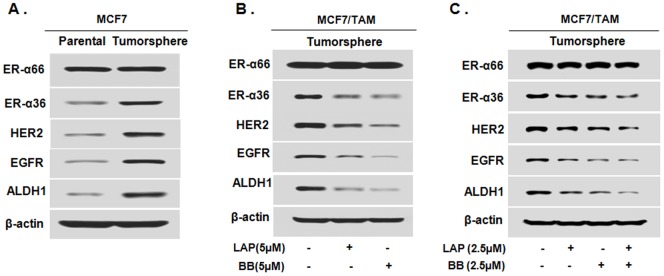
Tumorsphere cells derived from ER-positive breast cancer MCF7 cells express ER-α36-EGFR/HER2 positive regulatory loops.A. Western blot analysis of the expression of ER-α36, ER-α66, EGFR, HER2 and ALDH1 in the monolayer MCF7 cells grown on attachment dishes (MCF7/P) and MCF7 tumorsphere cells grown on low-attachment dishes. B. Tumorsphere cells derived from MCF7TAM cells were treated with 5 µM of Broussoflavonol B (BB) or Lapatinib (LAP) for five days. Western blot analysis of expression levels of different proteins was performed. C. Tumorsphere cells derived from MCF7TAM cells were treated with 2.5 µM of Broussoflavonol B (BB), Lapatinib (LAP) or BB (2.5 µM) and LAP (2.5 µM) together for five days. Western blot analysis of expression levels of different proteins was performed.